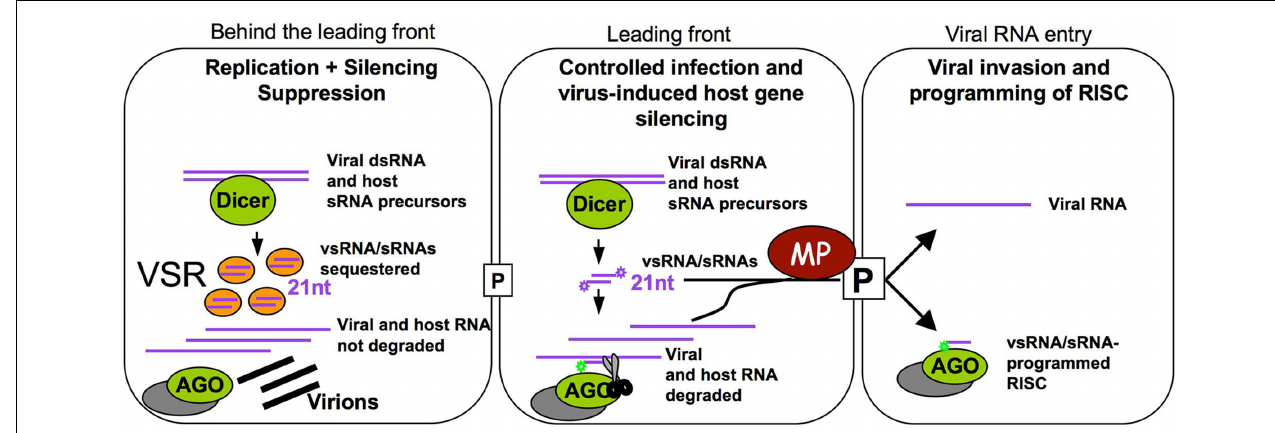
host transcripts and allow recipient cells to control the incoming virus. Our model also suggests that the tight viral control of its own accumulation and the manipulation of host gene expression could represent essential mechanisms sustaining successful infection. Once infection is initiated, the virus replicates and produces a sufficient amount of theVSR.Thus, in cells behind the leading front of infection, vsRNAs and host sRNAs are sequestered and inactivated, allowing the virus to accumulate and produce virions. Meanwhile, the leading front has moved into new